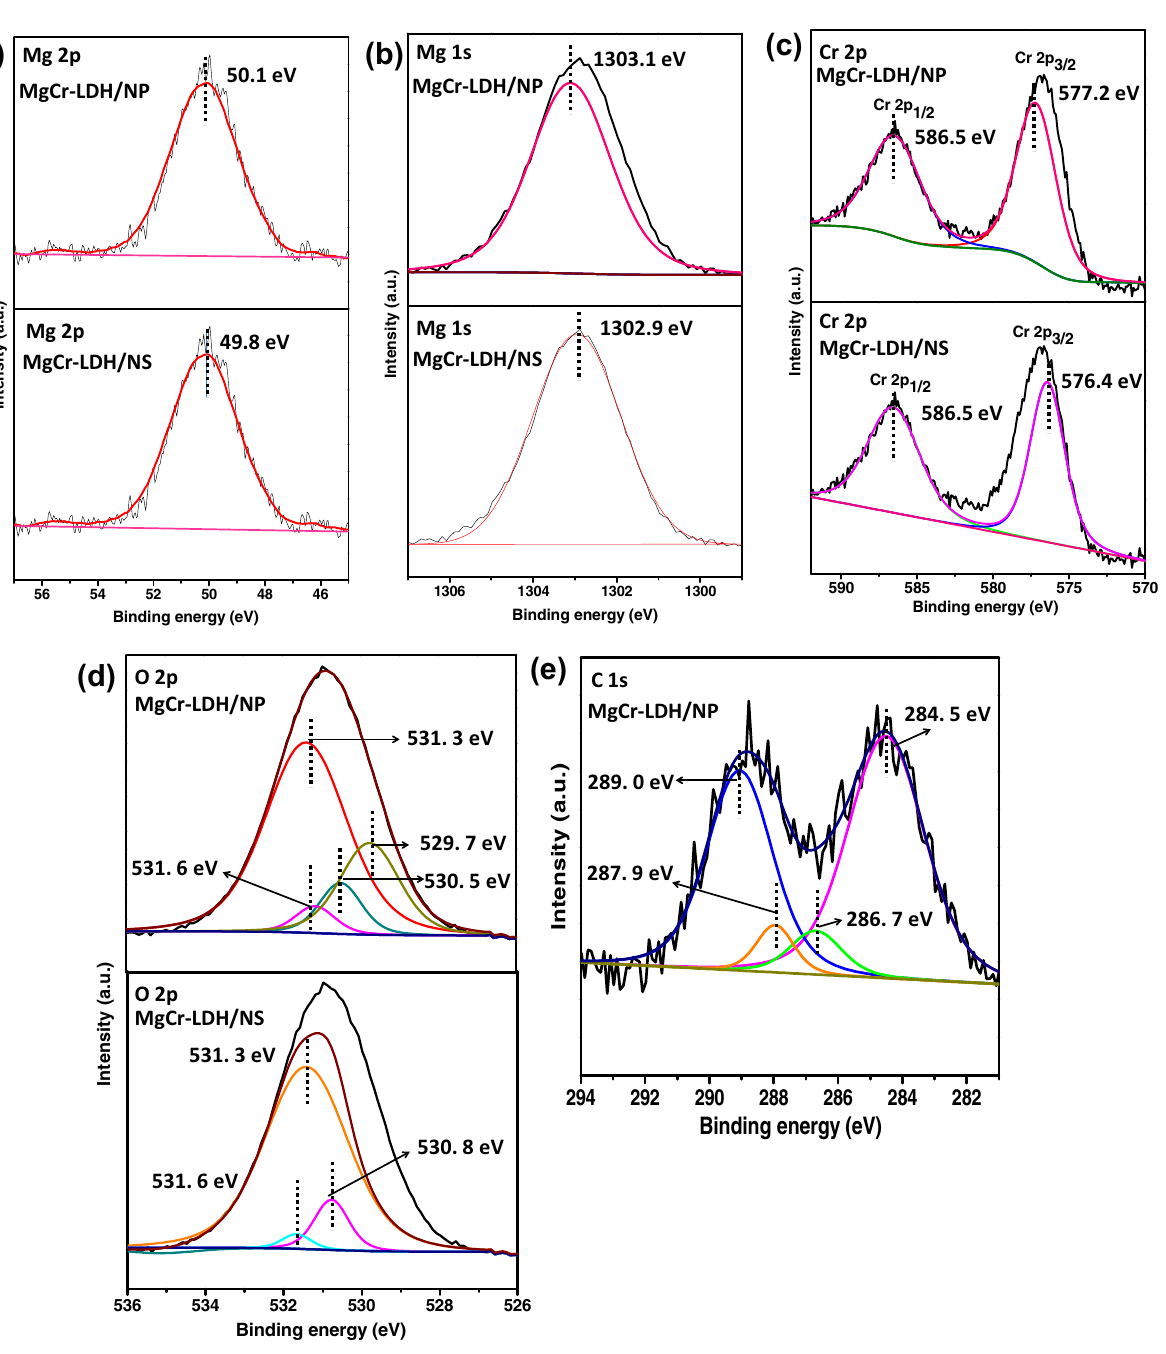
Figure 5. Analysis of the XPS results of the deconvoluted XPS spectra of MgCr-LDH/NS and MgCr-LDH/NP for Mg2p, Mg2s, Cr2p, O2p, and the function of photoinduced excitonic charge separation to intensify the net photocurrent as shown in Fig. 6a,b. The photocurrent measurement studies of the series of MgCr-LDH materials were recorded in potential panel of − 1.0 to 1.2 V vs. Ag/AgCl reference electrode using 0.1 M Na 2 SO 4 (pH = 6.5), at scan rate of 10 mV s −1 and converted to reversible hydrogen electrode (RHE) according to the Nernst equation.